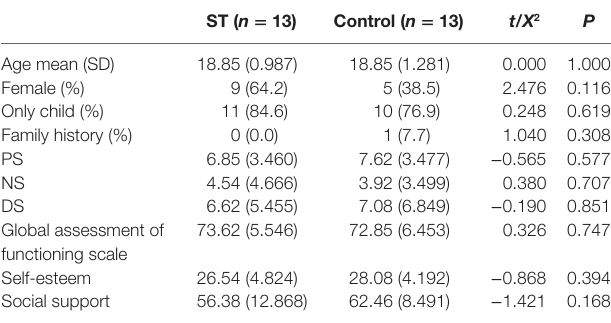
TaBle 2 | Baseline clinical and social demographic characteristics of two groups.